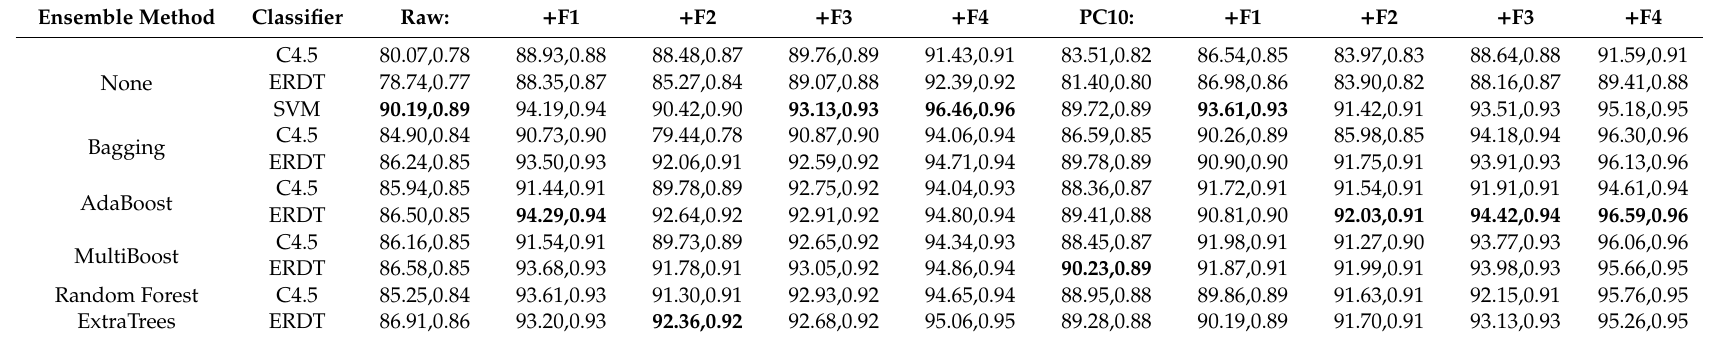
Table 2. The best OA and kappa statistics for considered classifiers using MPs, MPPR, OMPs and OMPsM features from PCA-transformed features of